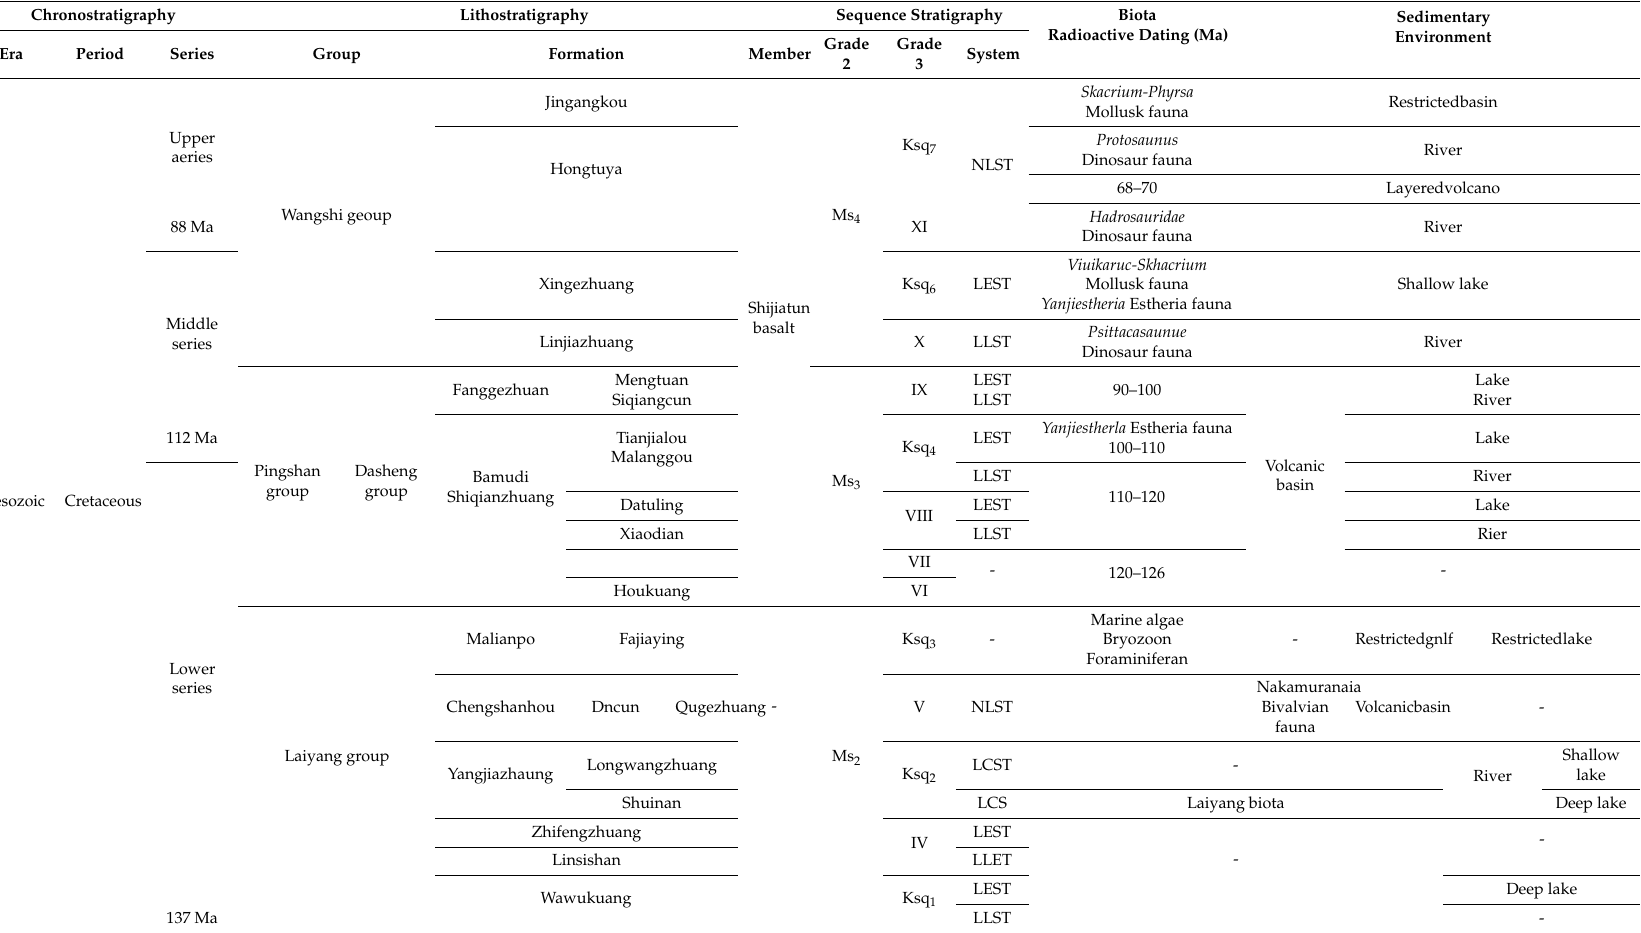
Table 2. Division and correlation of Cretaceous strata in